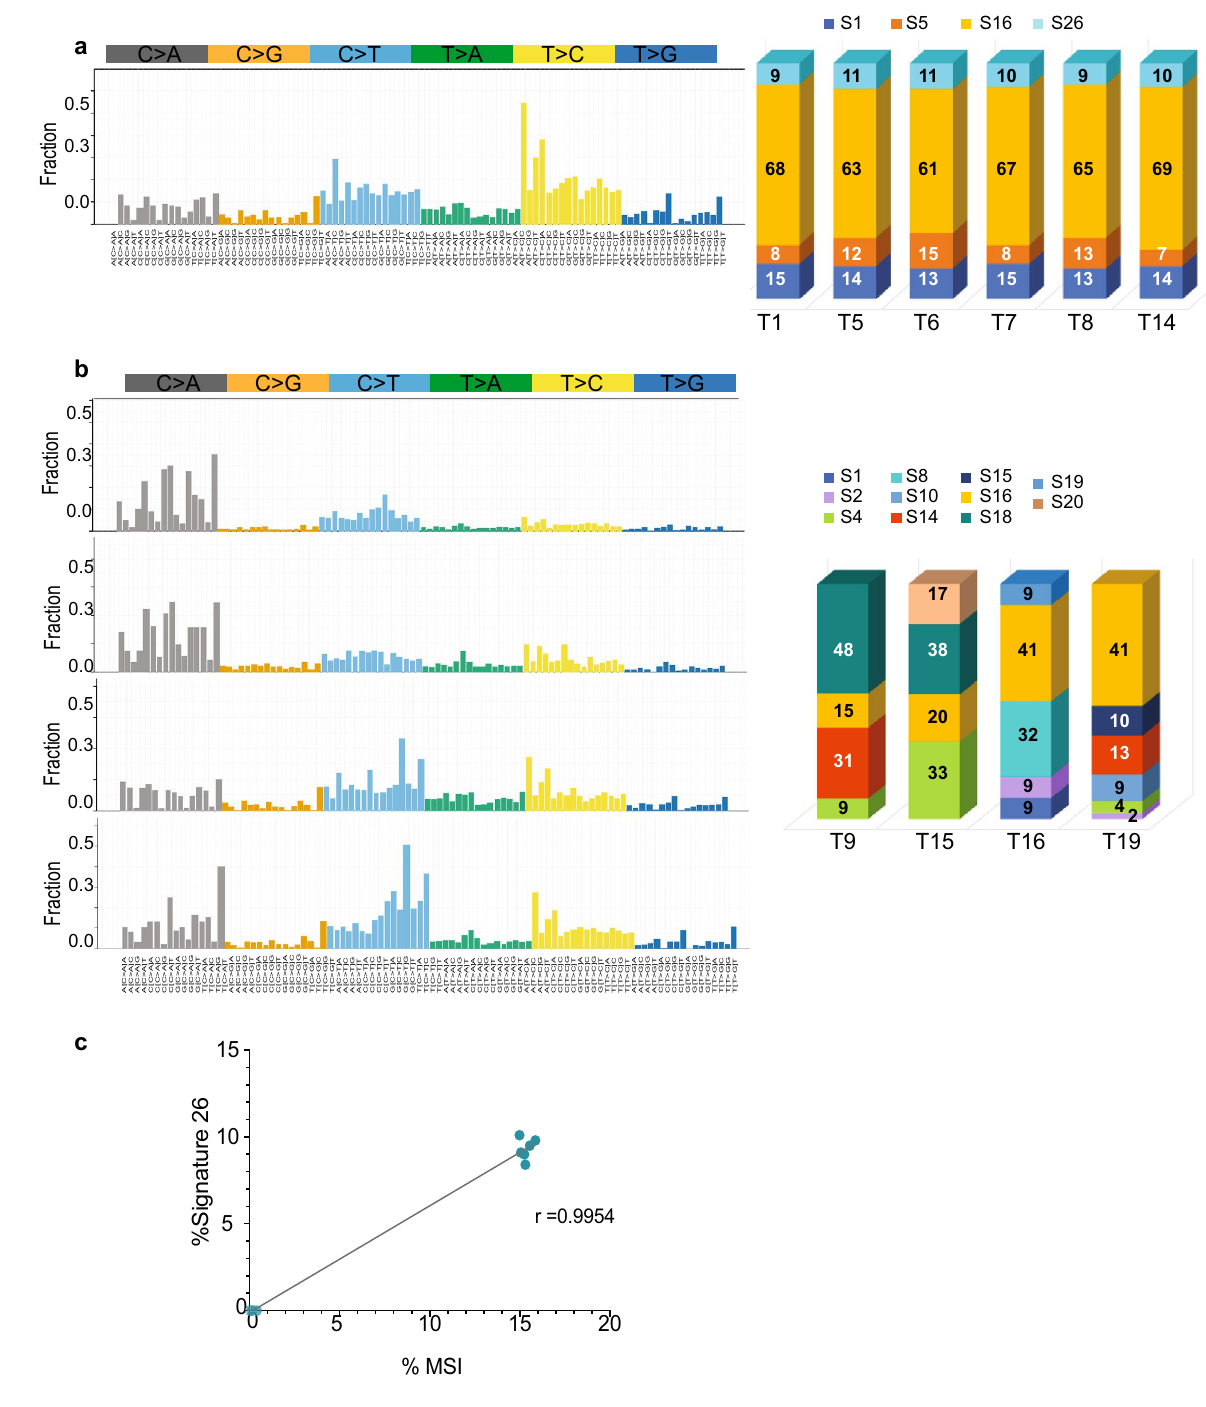
Figure 2. Mutational Signatures based on COSMIC Signatures extrapolate the nature of mutational processes in AA ESCC. ( a ) T > C mutations at ATN trinucleotides constitute Signature 16, which is demonstrated by yellow color in the bar graphs showing the fraction of mutational signatures contributed to whole mutations in each tumor sample. Signatures 1, 5, 16 and 26 were found in similar proportions (percentage) across the samples of T1, T5, T6, T7, T8, and T14. ( b ) Samples T9, T15, T16, and T19 contained various mutational signatures, each tumor sample had a unique mutational signature combination. Bar graphs shows the percentage of each signature in the tumor samples. ( c ) Signature 26 was correlated with percent microsatellite instability (%MSI) in Signature 16-high samples. Pearson correlation coefficient r was 0.9954 and 95% confidence interval 0.9799 to 0.9989. R 2 was calculated as